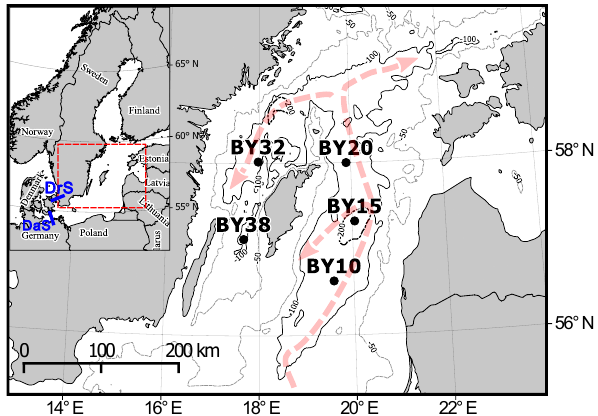
Figure 1. Map of the study area showing the five sampling loca- tions in the central Baltic Sea. The red arrows show the prevailing sub-halocline circulation of the central Baltic Sea, redrawn from Meier (2007). The sub-halocline circulation approximates the ex- pected route of major Baltic inflows (MBIs) along the transect of study locations. The inset shows the connection of the Baltic Sea to the North Sea via the Danish Straits (DaS: Darss Sill; DrS: Drog- den Sill). The numbers along the depth contours represent depth in